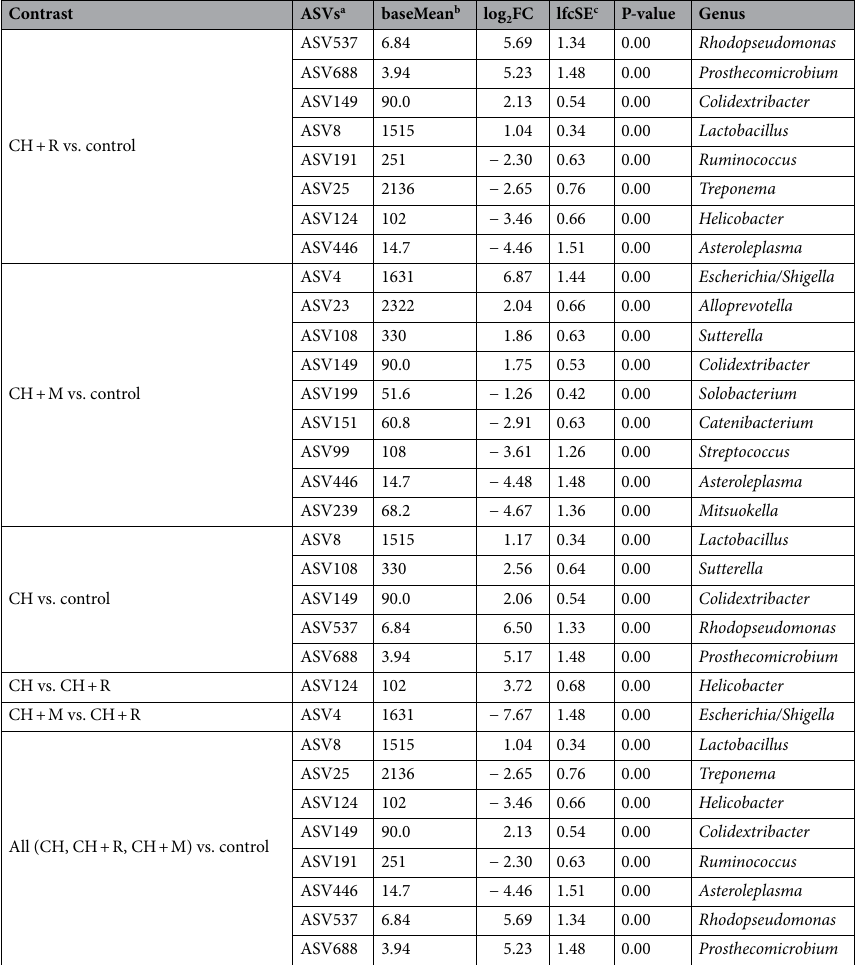
Table 5. DESeq2 output and contrast. Control = control diet; CH = Chlorella vulgaris diet; CH + R = C. vulgaris diet supplemented with Rovabio® Excel AP; CH + M = C. vulgaris diet supplemented with a pre-selected enzymatic mixture. a ASVs: abundant amplicon sequence variants. b baseMean: mean of normalized counts of all samples. c lfcSE: standard error estimated for the log2 fold